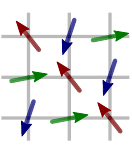
Figure 6: Magnetic order in the 120° magnetically ordered phase: the spins align in a plane and orient themselves at relative angles of